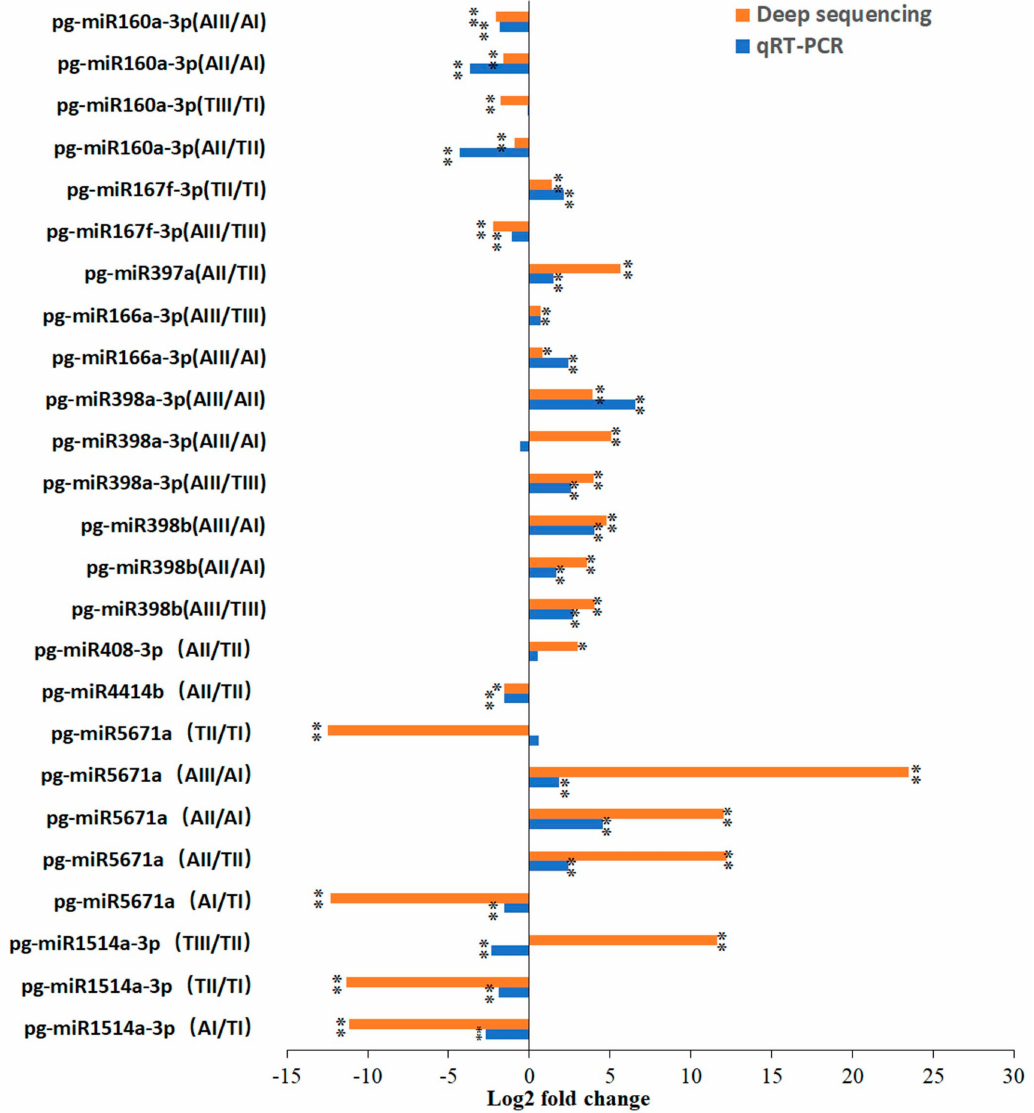
Figure 3. The qRT-PCR validation of di ff erential expression patterns of miRNAs between di ff erent stages. * p < 0.05 and ** p < 0.01 (Student’s t